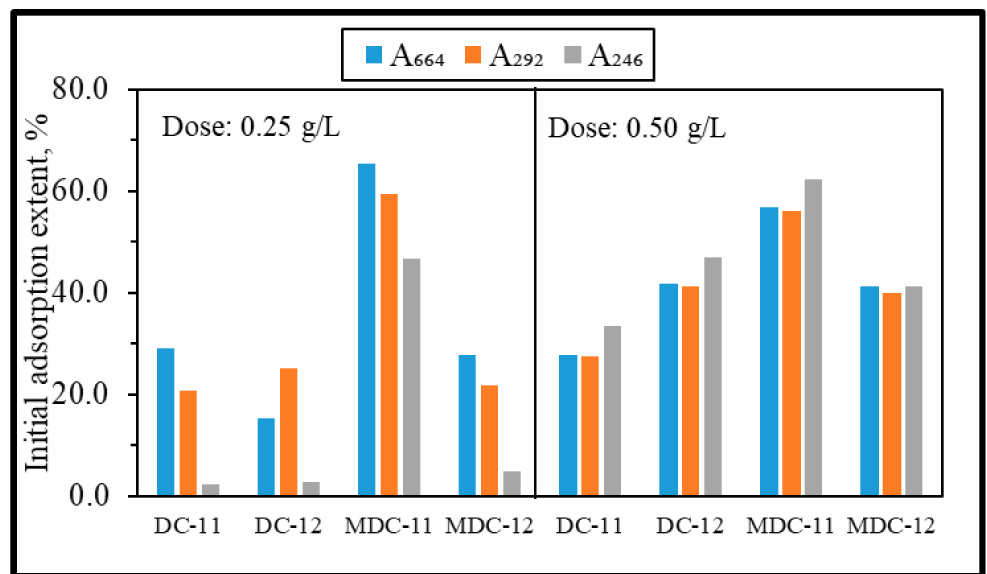
Figure 7. Dose dependent initial dark adsorption extents of MB onto DC-11, DC-12, MDC-11, and MDC-12, as expressed by all descriptive